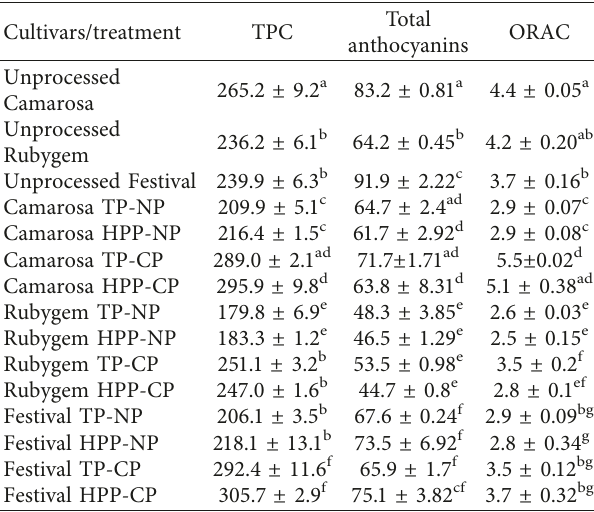
Data: means ± SD ( n � 3). Results are expressed in mg GAE/100g FW (TPC), μ mol/100g FW (anthocyanins), and mmol TE/100g FW (ORAC). FW: fresh weight; anthocyanins: sum of cya-3-glc, pel-3-glc, and pel-3-rut (expressed as pel-3-glc); TP-NP: non-copigmented thermally processed; TP-CP: copigmented thermally processed; HPP-NP: non-copigmented high-pressure processed; HPP-CP: copigmented high pressure processed; TPC: total phenolic content. Different letters within a group in a column indicate a significant difference ( p < 0 . 05), the groups being unprocessed samples, processed Camarosa samples together with unprocessed Camarosa, processed Rubygem samples with unprocessed Rubygem, and processed Festival samples with unprocessed